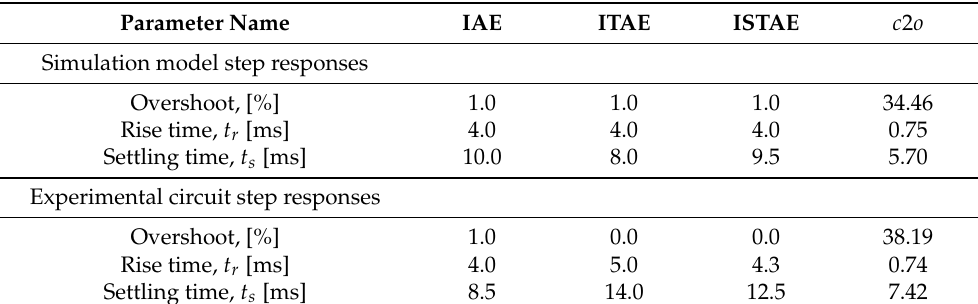
Table 7. Selected parameters of step responses from Figure 11 for gains from Table 6 obtained with GA optimization, with GM = (cid:104) 10,20 (cid:105) dB and PM = (cid:104) 80,90 (cid:105) °